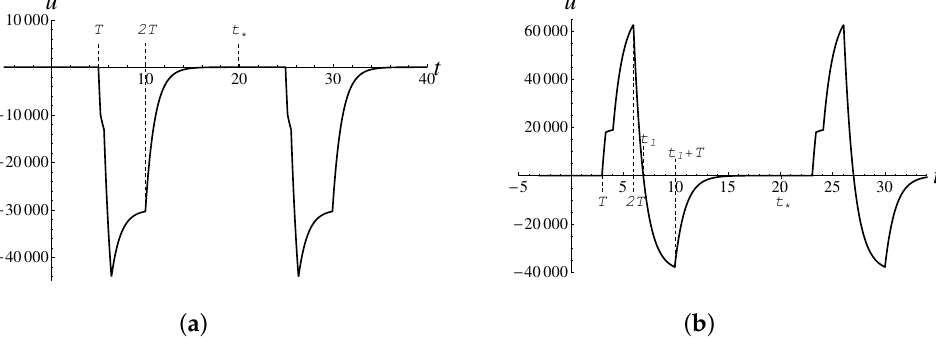
Figure 5. Relaxation cycles of Equation (2) in the case that b = 0 and d < 0 and function f ( u ) satisfies the conditions of ( a ) (38) and ( b ) (42). Values of parameters: λ = 10 4 , p L = − 1.5, p R = 2.5, b = 0, ( a ) T = 5, d = − 2, ( b ) T = 3, and d = −